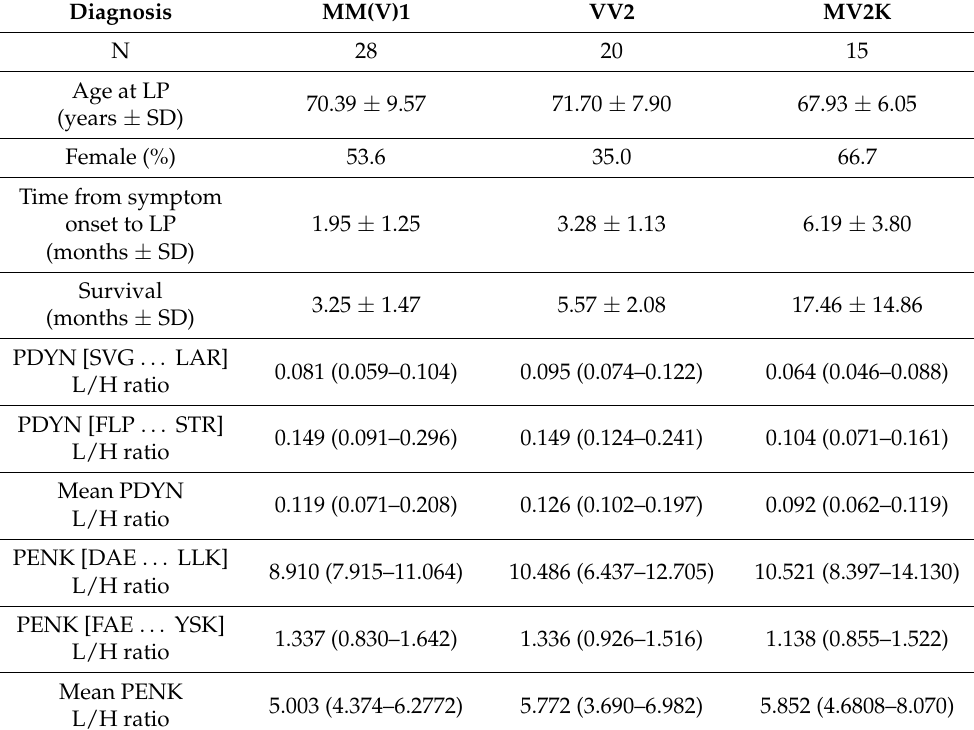
Table 2. Distribution of PDYN- and PENK-derived peptides among sCJD